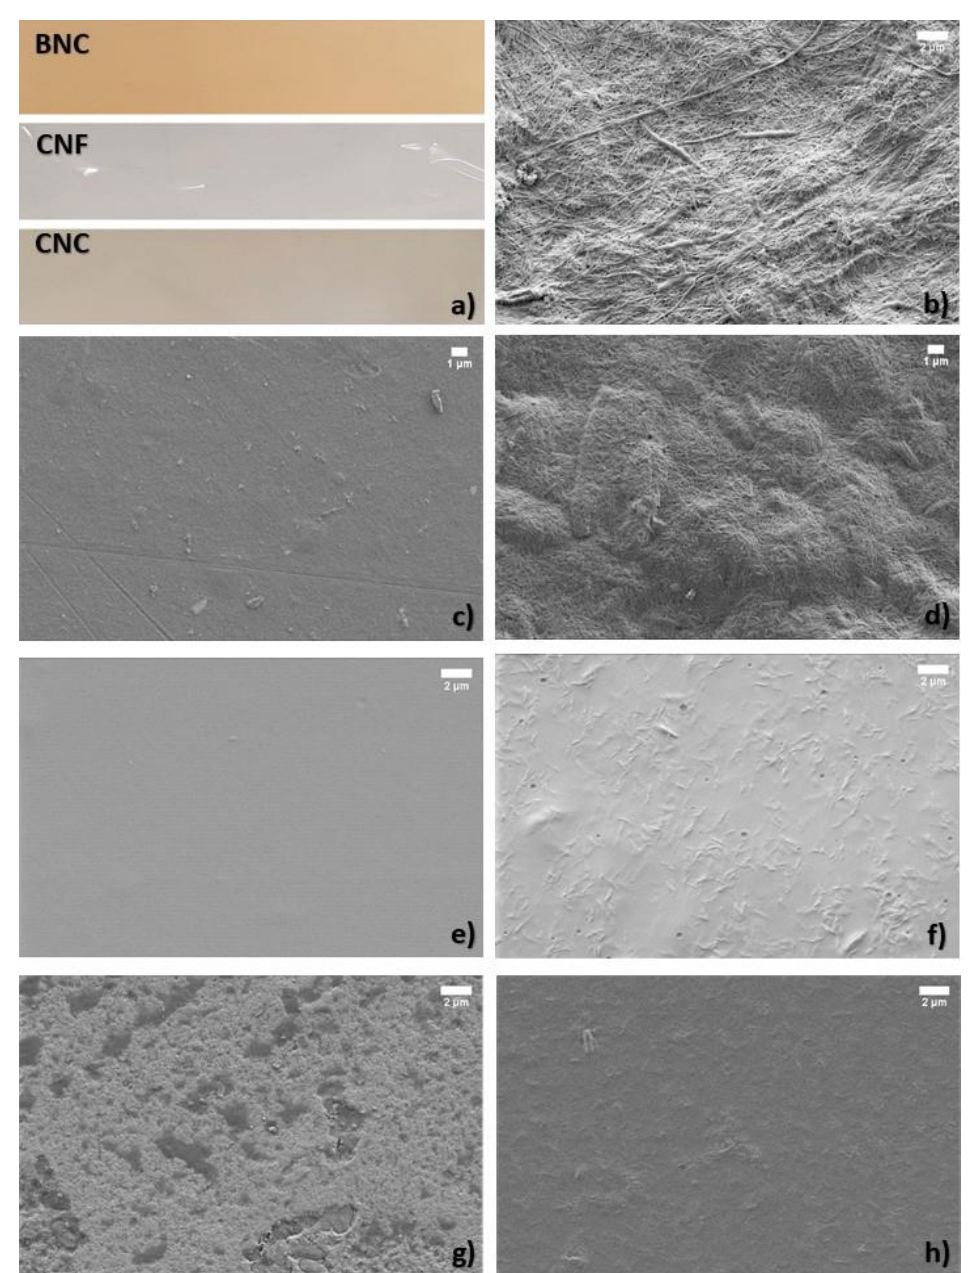
Figure 4. ( a ) Visualisation of BNC, CNF, and CNC films. SEM micrographs of ( b ) BNC, ( c ) CNF film with 30 wt% glycerol, ( d ) CNC film with 30 wt% glycerol, ( e ) chitosan film with 30 wt% glycerol, ( g ) alginate + 5% CNC, ( f ) chitosan + 3% CNC, and ( h ) alginate film with 30 wt% glycerol.